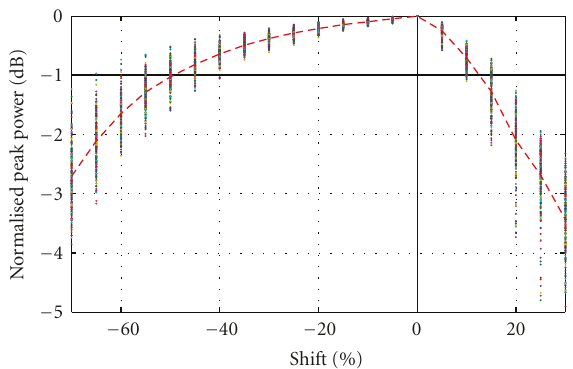
Figure 3: Received signal peak power with left and right shifts normalized to the peak with no shift.